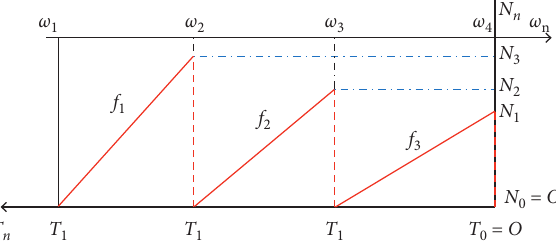
Figure 24: The description of the degradation process of spans throughout a defined